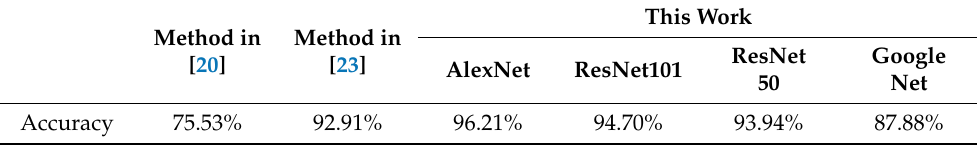
Table 9. Image recognition accuracy obtained from a different CNN